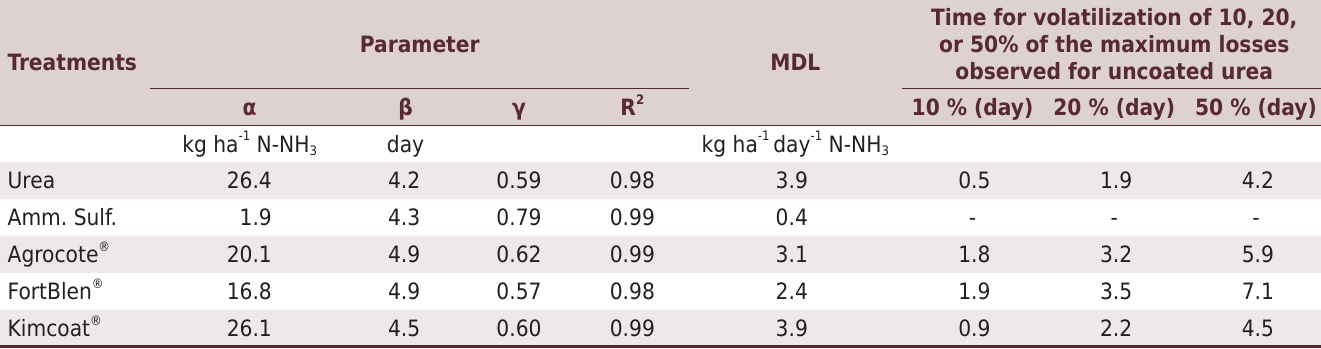
Table 1. Parameters of the sigmoid regression adjusted for the cumulative losses of NH 3 . Time span for fertilizer-controlled release to lose 10, 20, or 50 % of the maximum losses of NH 3 by volatilization that occurred with urea (26.4 % of the N applied) Parameter Treatments